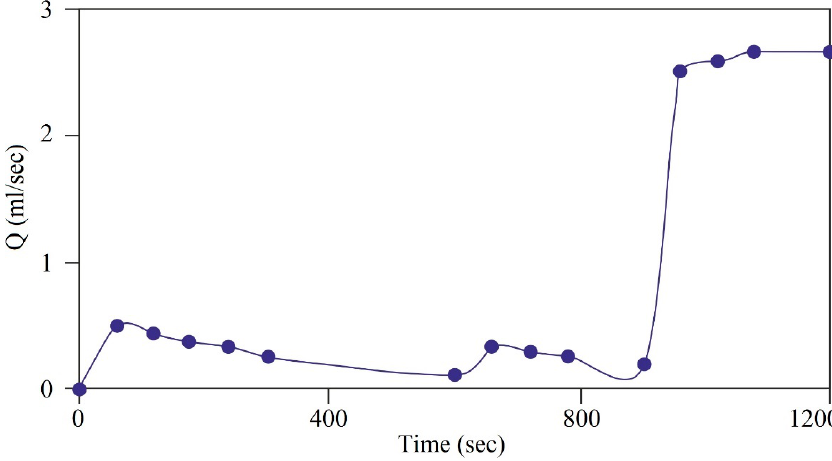
Figure 9. Variation of water flow in a clayey soil sample without additives.